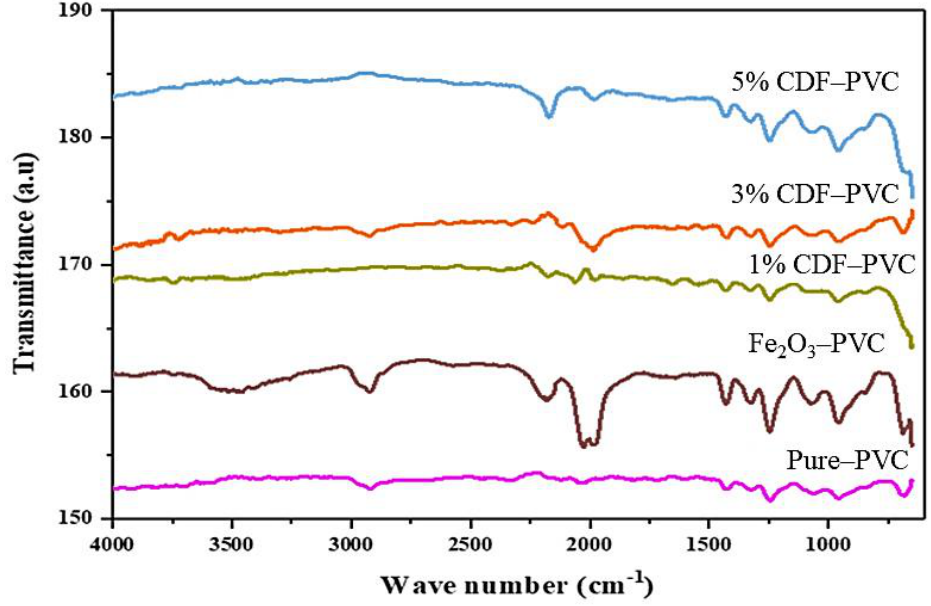
Figure 4. A comparison of the FTIR spectra of PVC and its composites. Table 1. Peak assignment values of FTIR spectra of PVC composites.